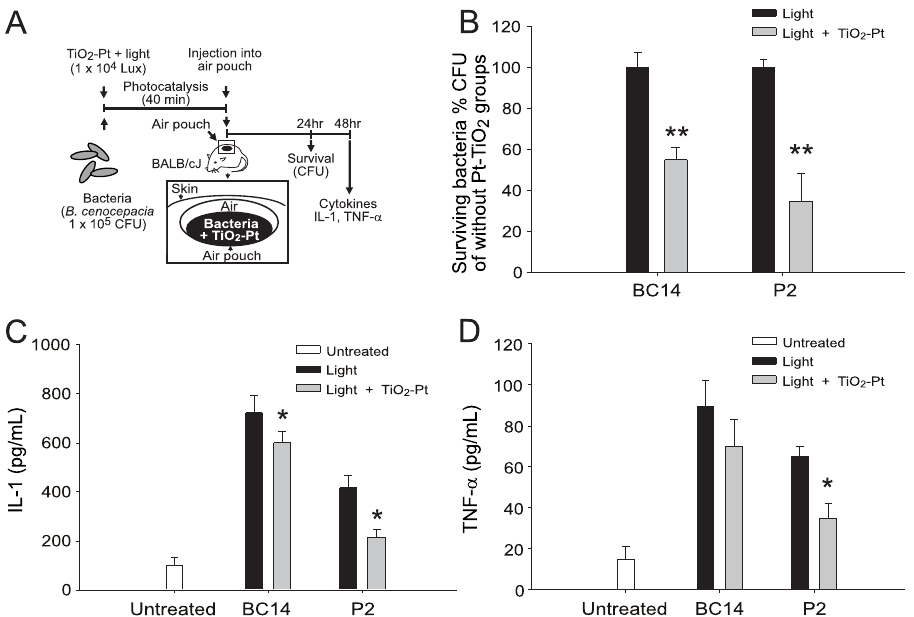
Figure 4. Bacterial survival and inflammatory cytokine production in mice. The experimental outline of the air pouch infection mouse model is shown (A). The survival rate of B. cenocepacia cells (strains BC14 and P2), which were treated with or without photocatalysis, was recorded 24 hours after subcutaneous injection into mice. ** P , 0.01, compared to the respective without-photocatalyst groups (B). The levels of the inflammatory cytokines IL-1 (C) and TNF- a (D) in the air pouches underneath the mouse skin were also determined. * P , 0.05, compared to the respective without-photocatalyst groups. n=6, three experiments with 2 replicates. The data are presented as mean 6 SD.